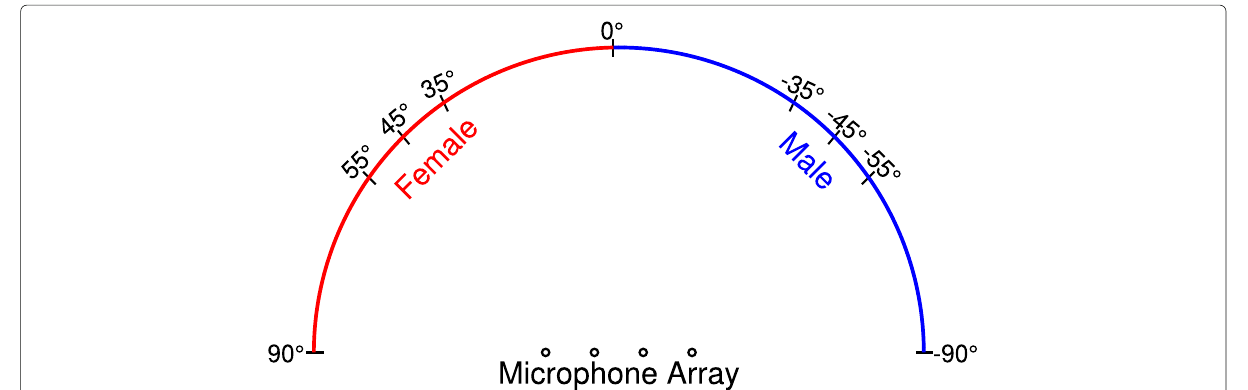
Fig. 4 The recording setup for the experiment in Section 4.2. Black circles denote the position of microphones. The red and blue lines show the path of the female and male speakers,